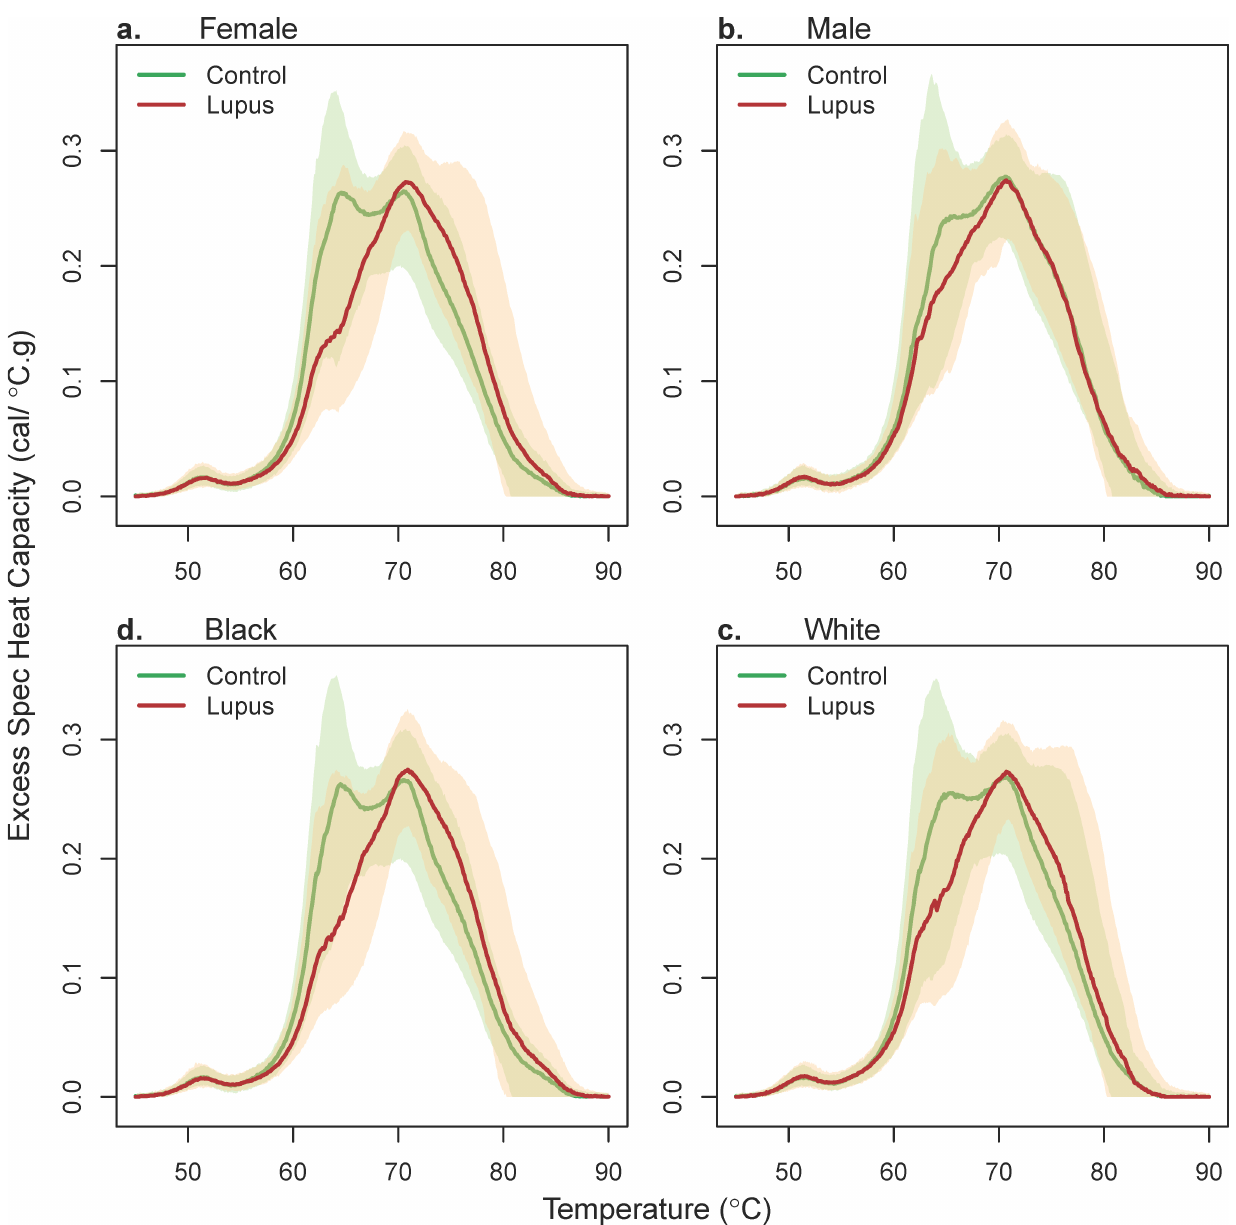
Fig 3. Plot of the median thermogram value at each temperature for lupus and control subjects stratified by gender and ethnicity. Bands representthe 5th and 95th percentiles amongsubjects at each temperature.